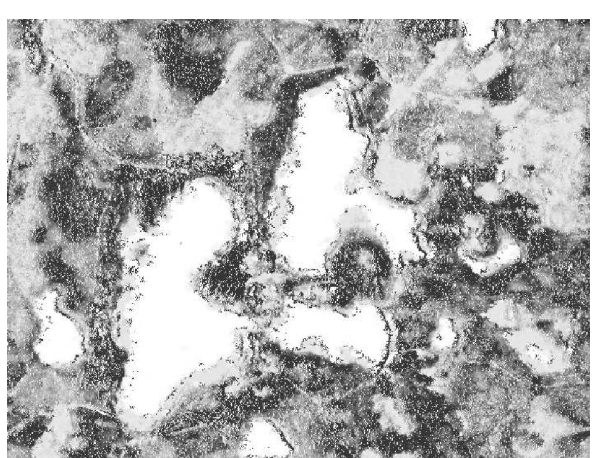
Figure 4. Canopy height model (10 m resolution) derived using interferometry.